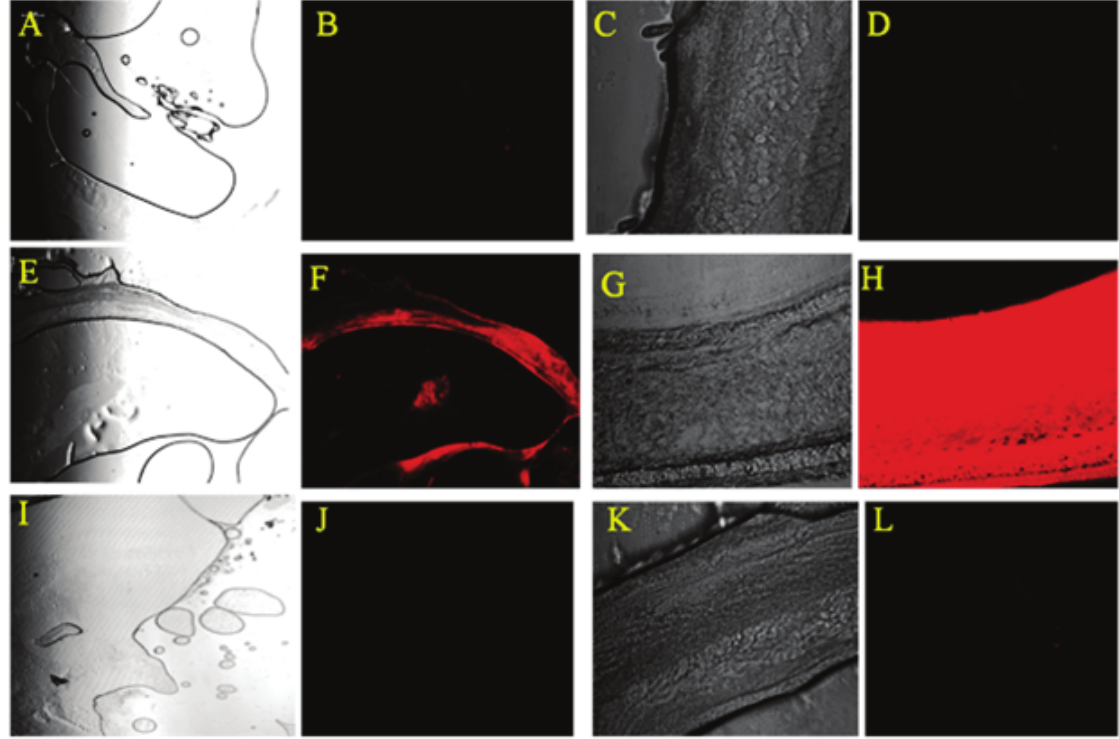
Figure 6. Confocal microscopy of the retinoblastoma and retina at 24 hr after intravitreal injection of CY5-labeled NPs into the vitreous cavity of rat with retinoblastoma. (A–E) Control group; untreated retinoblastoma (A) and untreated retina (C). (E–H) Eyes injected with Cy5-labeled CMD-TCs-NPs. The Cy5-labeled CMD-TCs-NPs diffused to the tumor mass (F) and through the retinal layers (H). (I–L) Eyes injected with Cy5-labeled CMD-TMC-NPs. Cy5-labeled CMD-TMC-NPs are entirely trapped in the vitreous and are not able to reach the retina even after 24